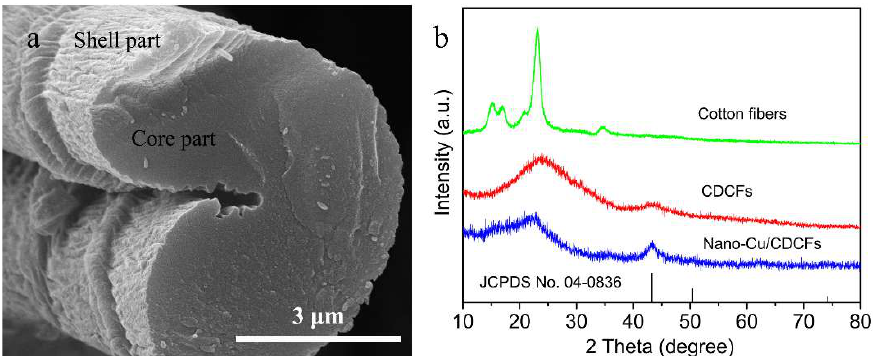
Figure 3. ( a ) cross-section SEM image of nano-Cu/CDCFs; ( b ) XRD patterns of the cotton fibers, CDCFs and nano-Cu/CDCFs, and the bottom line is the standard JCPDS card no. 04-0836 for Cu.